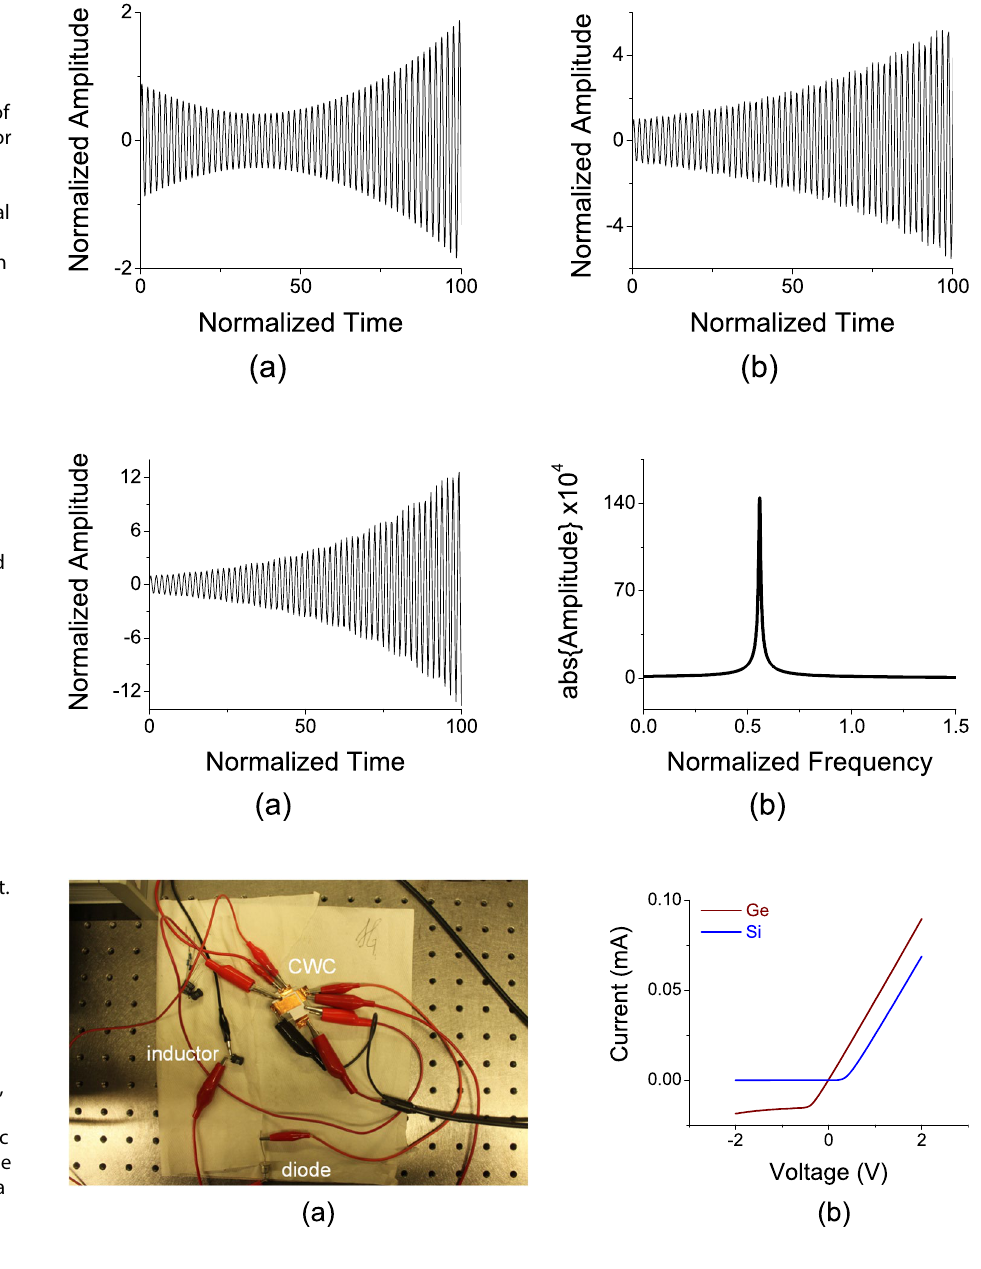
Fig. 3 Normalized amplitudes of the signal as a function of normalized time for: a para- metric frequency of Eq. 2 and b with parametric frequency of Eq. 3. In the harmonic oscillator equation (Eq. 4), the Normal- ized Amplitude, y multiplies the square of normalized radial frequency of either Eq. 2, or Eq. 3. The normalized time is in units of 1/2πf p